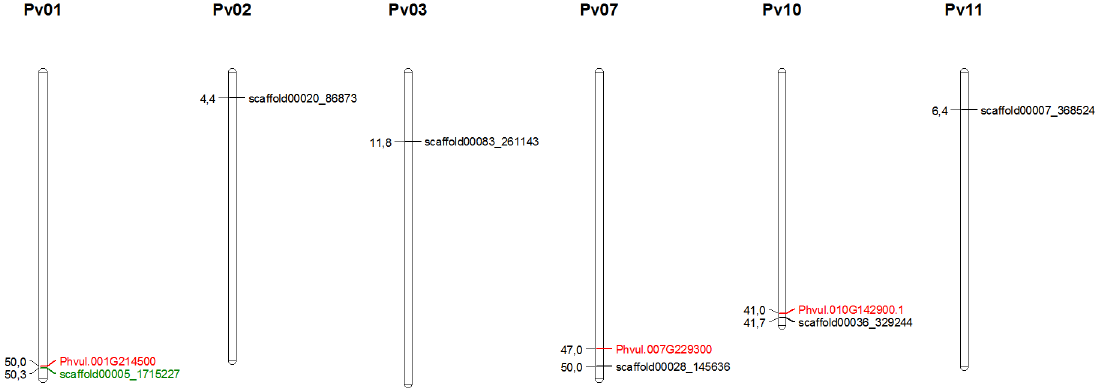
Fig 4. Representative map of the genome positions of markers associated (P < 0.05) with DFF and DTF, and potential positional candidate genes. Pv: Phaseolus vulgaris chromosome. SNP markers were located based on the reference genome [20] using the Phytozome v11.0 BLAST tool (http://www.phytozome.net/). Markers in black are associated with DTF and those in green are associated with DTF and DFF jointly. Candidate genes are in red. The map was drawn with MapChart [38], and marker positions are represented in Mb.